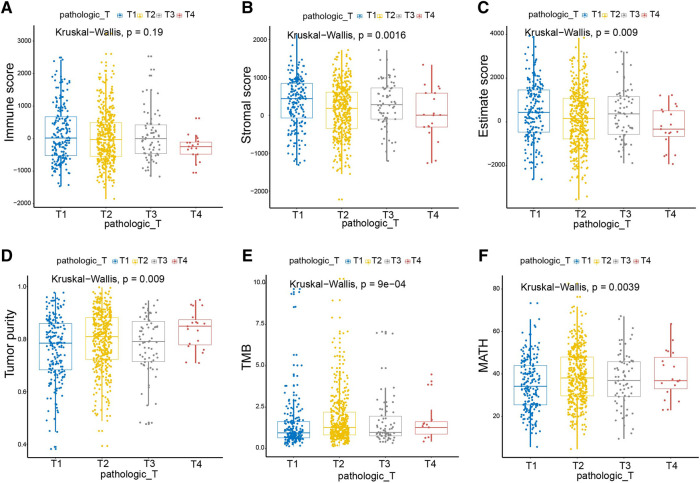
Immune and Stromal scores were significantly associated with the T stages of breast cancer. As the T stage progressed, the Immune score, Stromal score, and Estimate score decreased, and the scores of Tumor purity, TMB, and MATH increased. Pathologic_T, pathological T staging of tumor, represented by T1-T4 in turn. Kruskal_Wallis, the kruskal wallis test was used to compare multi-independent samples.